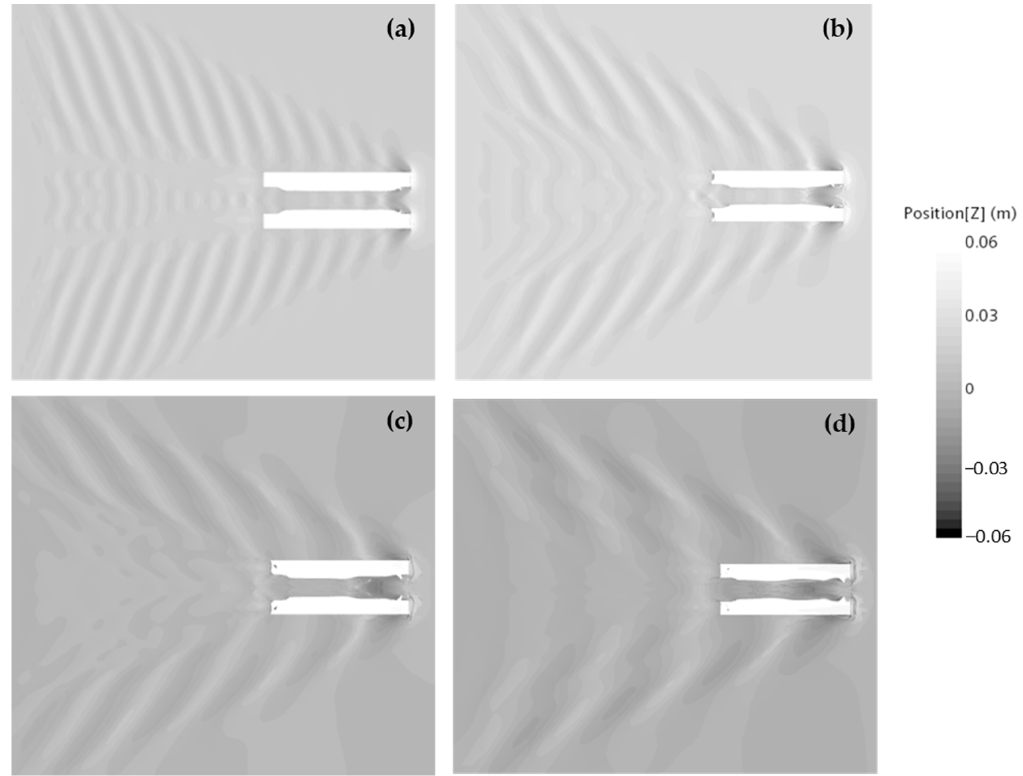
Figure 11. Wave pattern of amphibious vehicle w/o caterpillars at Fn of: ( a ) 0.17, ( b ) 0.22, ( c ) 0.27, ( d ) 0.32.